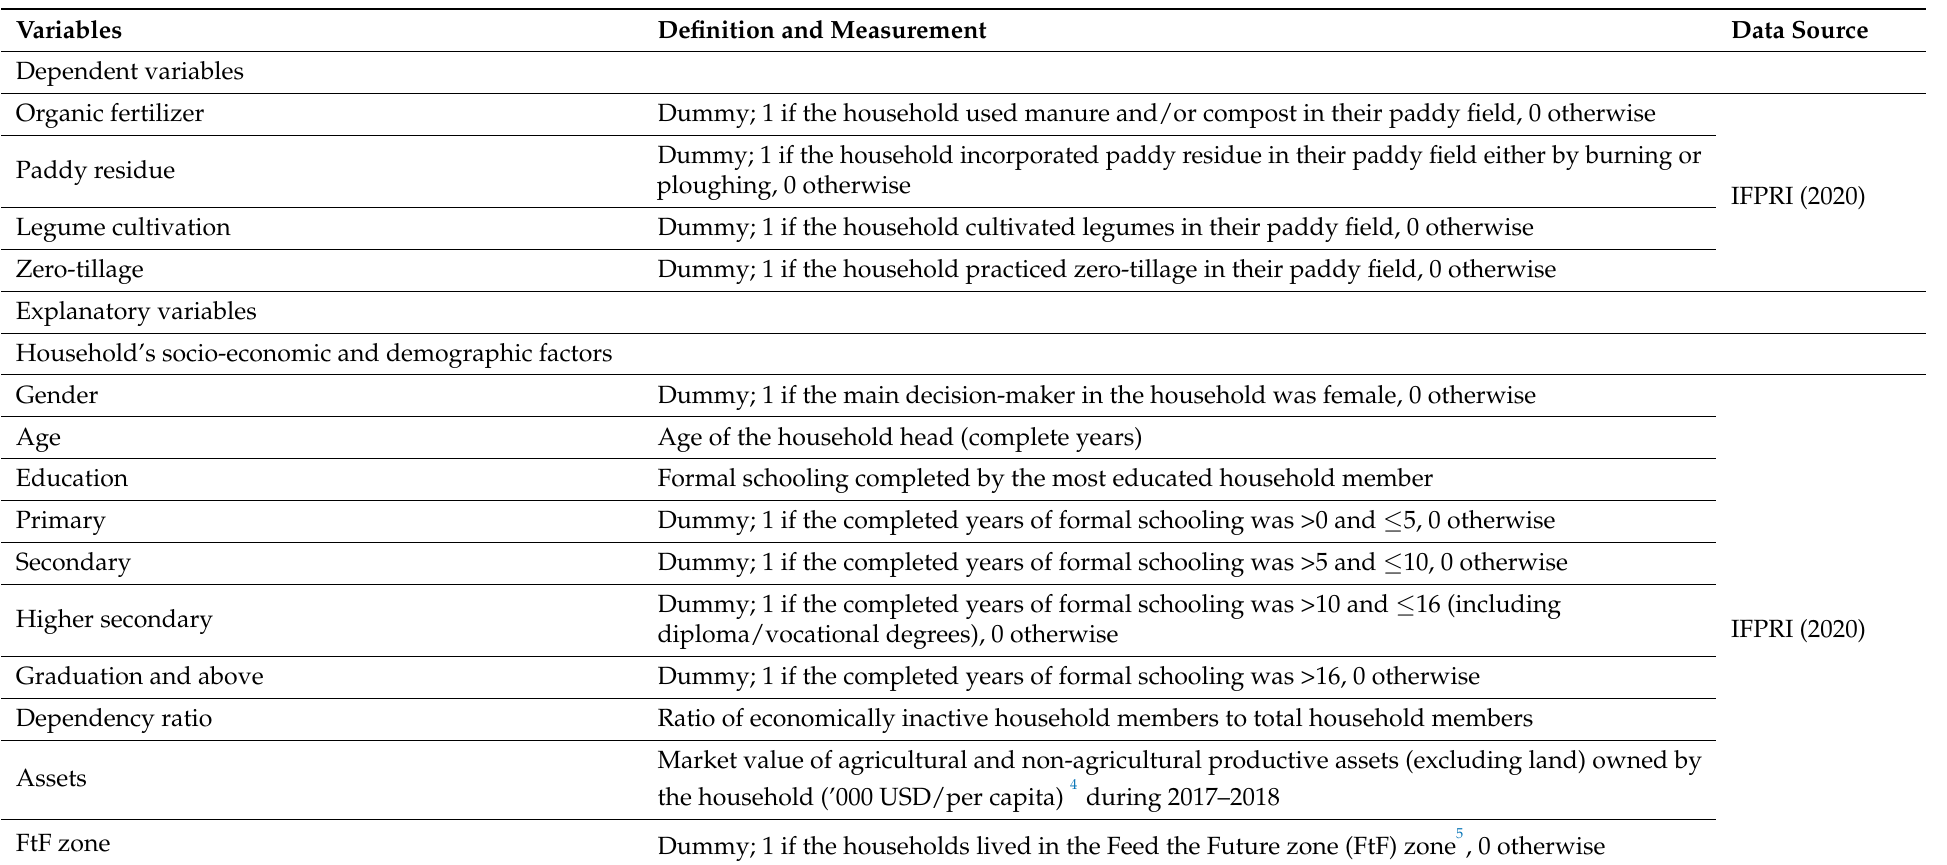
Table 1. Description of the explanatory variables used in the MVP